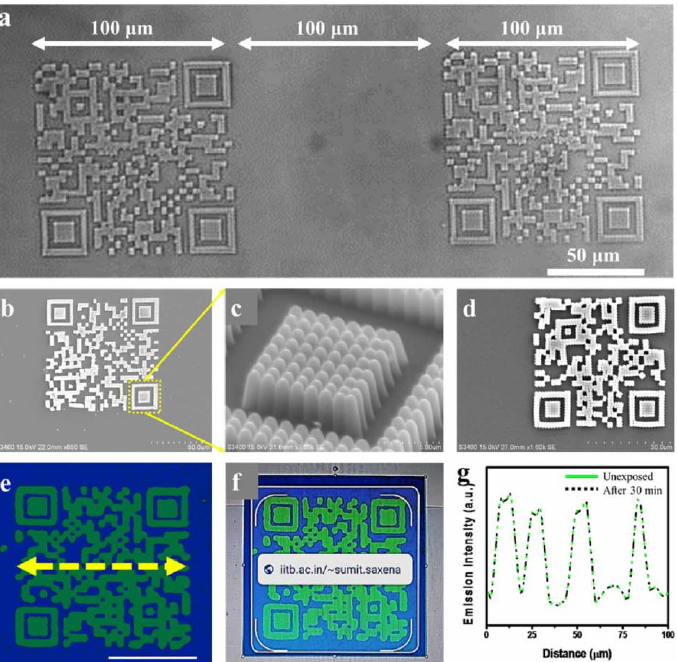
Figure 7. ( a ) Optical image showing two identical QR codes (100 × 100 μm 2 each), separated by 100 μm, demonstrating reproducibility. ( b ) SEM image showing the top view of the QR code shown in image ( a ). ( c ) Zoomed-in, tilted (30°) view of ( b ), showing the architectural details of the micro-QR code. ( d ) Top view obtained by SEM imaging, showing micro-QR codes fabricated over an area of 50 × 50 μm 2 , demonstrating scalability. ( e ) Fluorescent image obtained from a sample stored under ambient light conditions for a three- month period (scale bar: 50 μm). ( f ) Readout obtained from the image shown in ( e ). ( g ) Average emission intensity profile of ( e ) over a central zone of the QR code (marked with by the yellow line) immediately after UV excitation (green) and after 30 min of con- tinuous irradiation (black, dotted line). Reproduced from Reference [26], Jaiswal et al. J. Phys. Pho- tonics 2021 , 3 , 034021, https://doi:10.1088/2515-7647/ac0959, under the terms of the Creative Com- mons Attribution 4.0 licence.